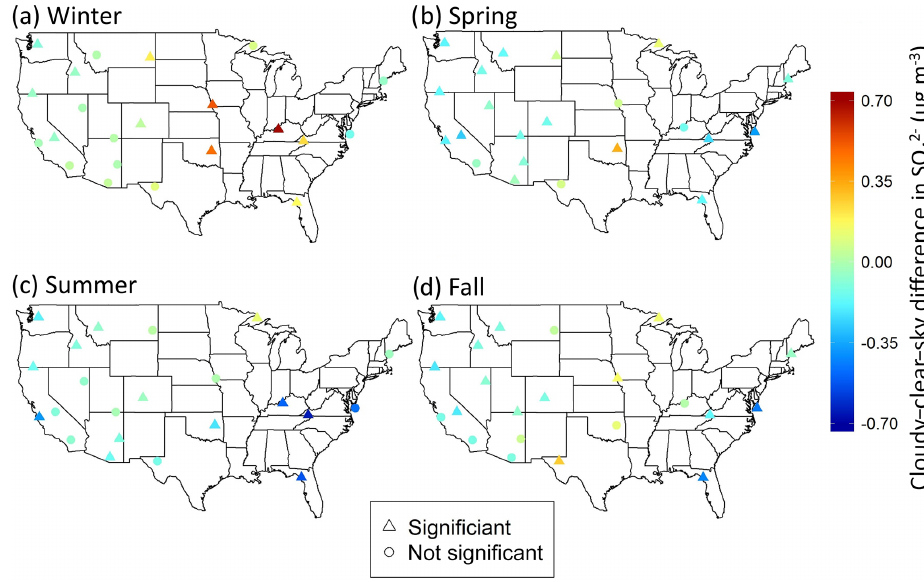
Figure A2. Maps of the difference in SO 2 − mass concentration medians (cloudy–clear-sky) for all regions from 2010 to 2014 for (a) winter, 4 (b) spring, (c) summer, and (d) fall. The color of the point corresponds to the magnitude of the difference. Triangles indicate that median differences are significant according to the Mann–Whitney U